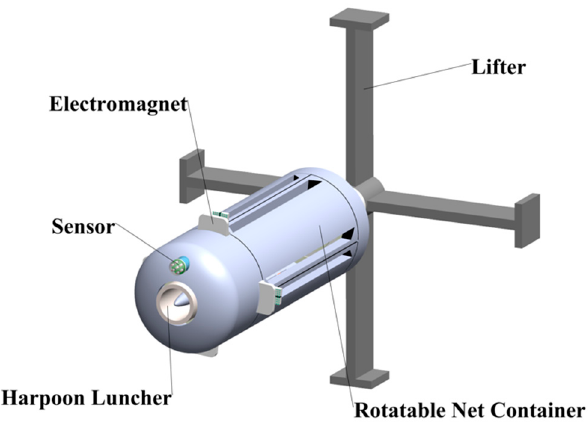
Figure 4. The tethered net payload.